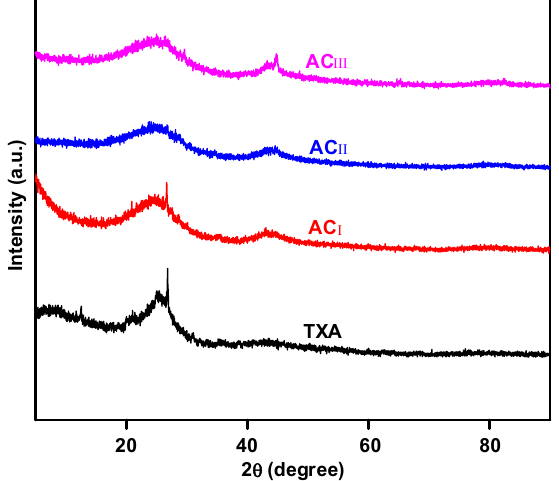
Figure 2. XRD patterns of TXA, AC I , AC II and AC III .